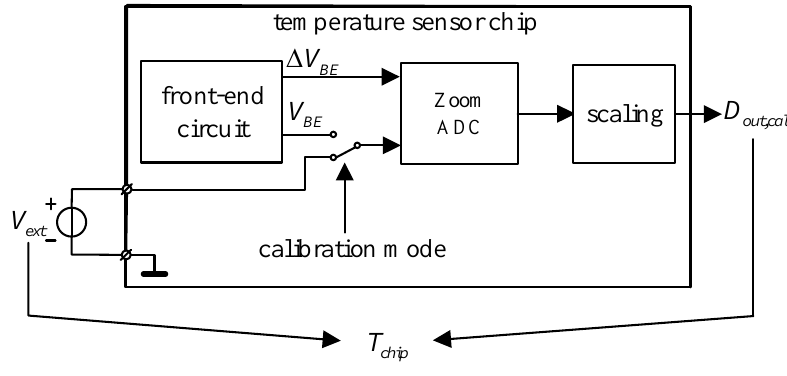
Figure 6. Overview of the temperature sensor.